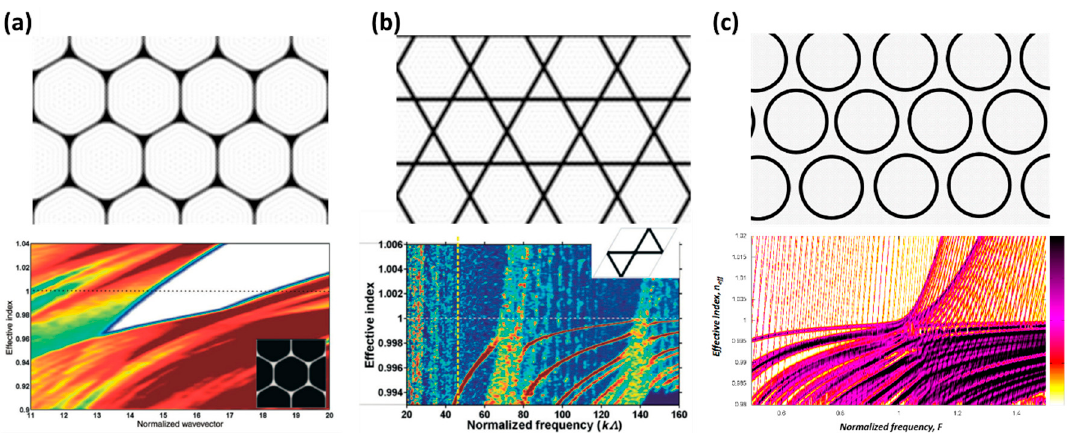
Figure 5. Representative DOPS of ( a ) PBG (reprinted with permission from Reference [7], Francis & Taylor, 2011), ( b ) IC Kagome (reprinted with permission from Reference [7], Francis & Taylor, 2011), and ( c ) IC Single Ring Tubular Lattice HCPCF (reprinted with permission from Reference [30], OSA, 2017).